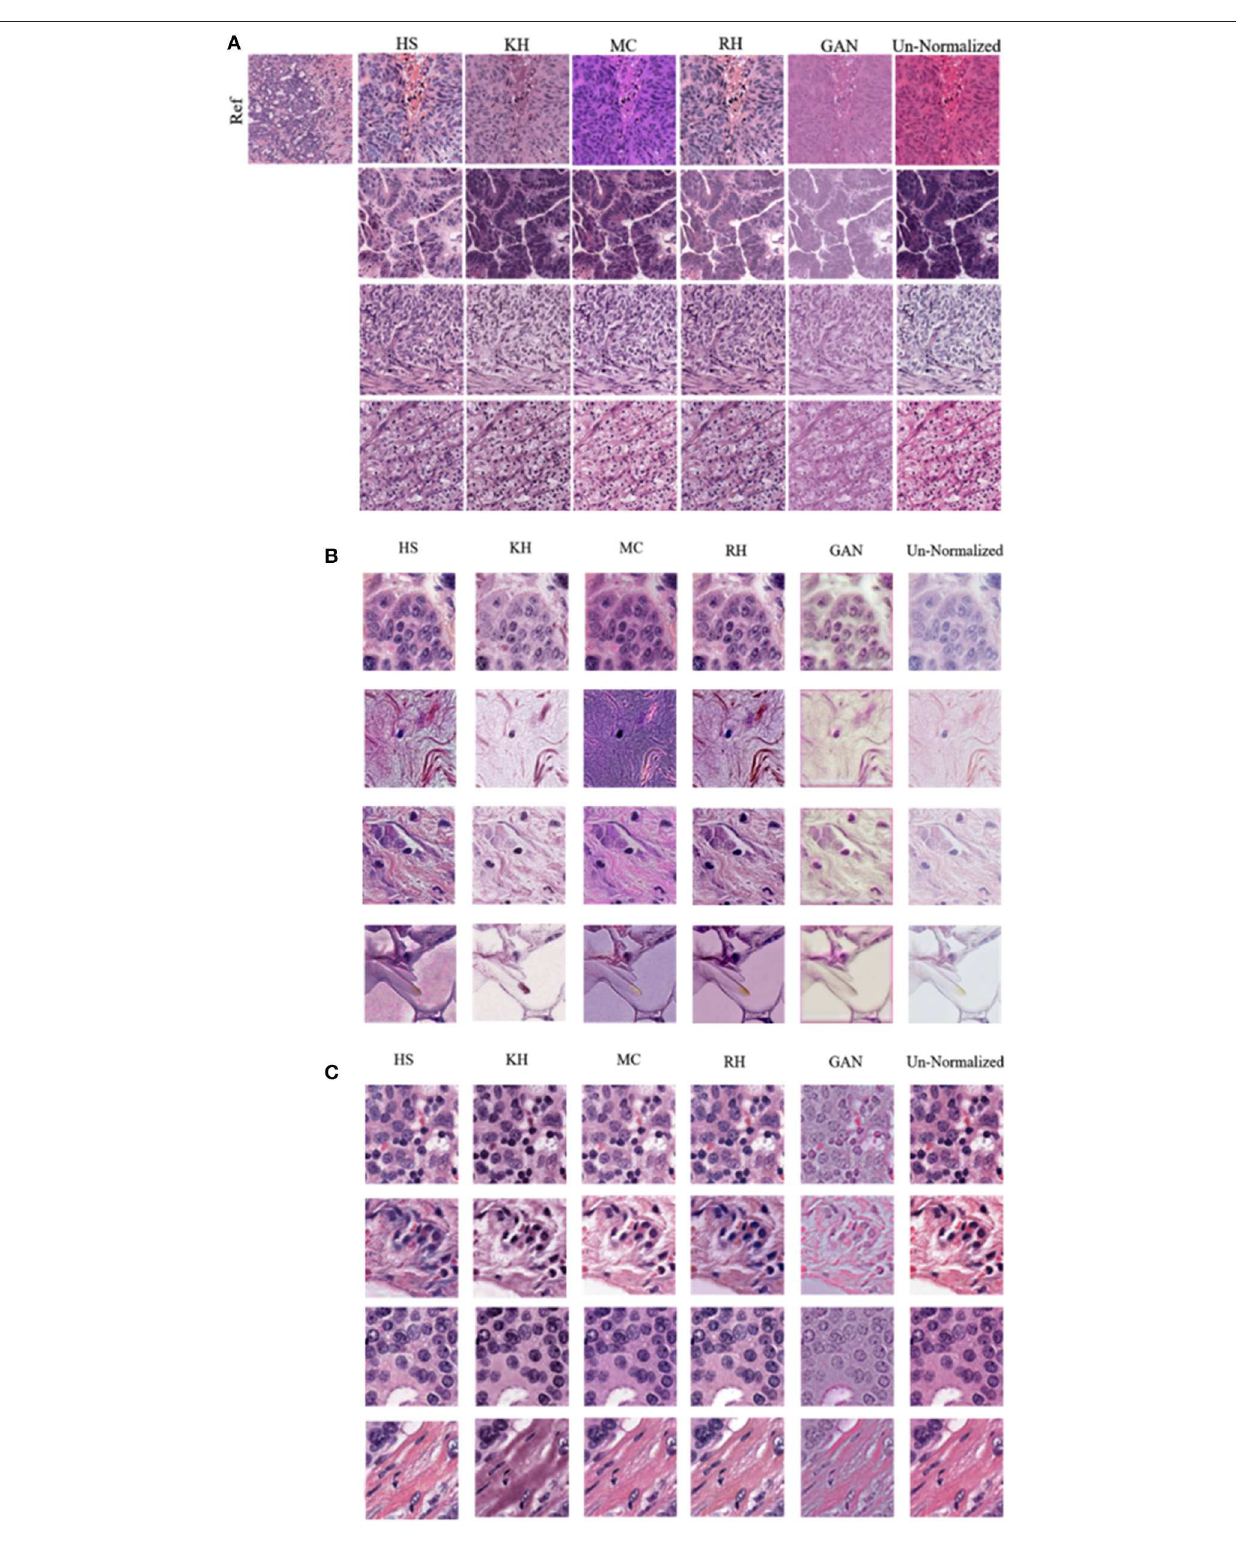
Frontiers in Bioengineering and Biotechnology |